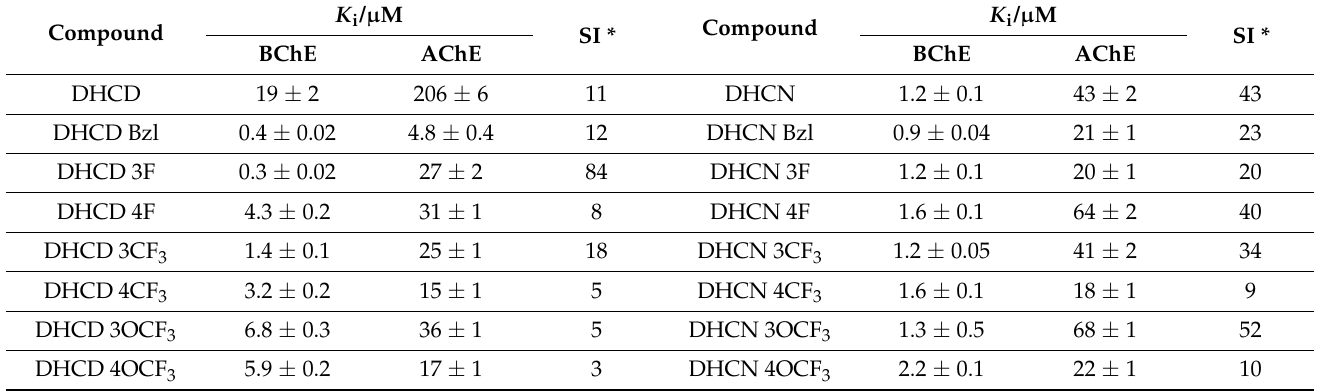
Table 2. Inhibition of AChE and BChE by derivatives of 10, 11-dihydrocinchonine and 10, 11-